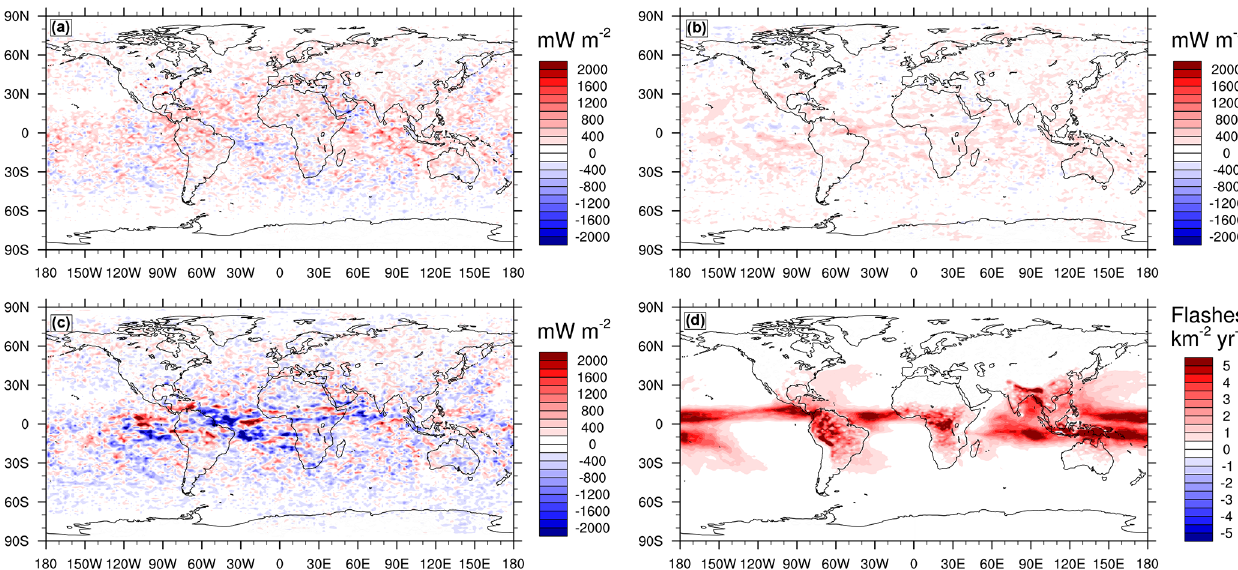
Figure 5. Global distribution of the all-sky radiative flux difference (mWm − 2 ) between Run C (i.e. the new dry deposition scheme and the new LNO x scheme) and the base run (mean over 2006–2010). The plots are for the (a) net downward TOA radiative flux difference ( (cid:49)R N ), (b) incoming longwave radiative flux difference at the surface ( (cid:49)L ↓ S ) and (c) incoming shortwave radiative flux difference at the TOA surface ( (cid:49)S ↓ S ). In (d) , the corresponding model difference in lightning flash density, given as flashes km − 2 yr − 1 , is shown.